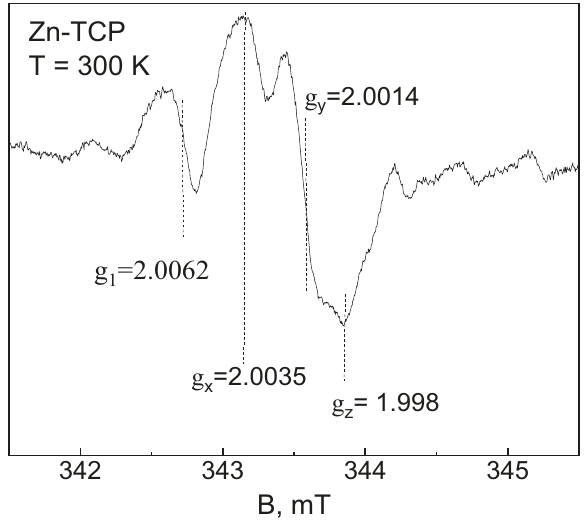
Fig. 4 Central part of the X-Ray induced EPR for Zn-TCP powder sample annealed at 900 °C after 512 scans. The calculated values of g-factors are